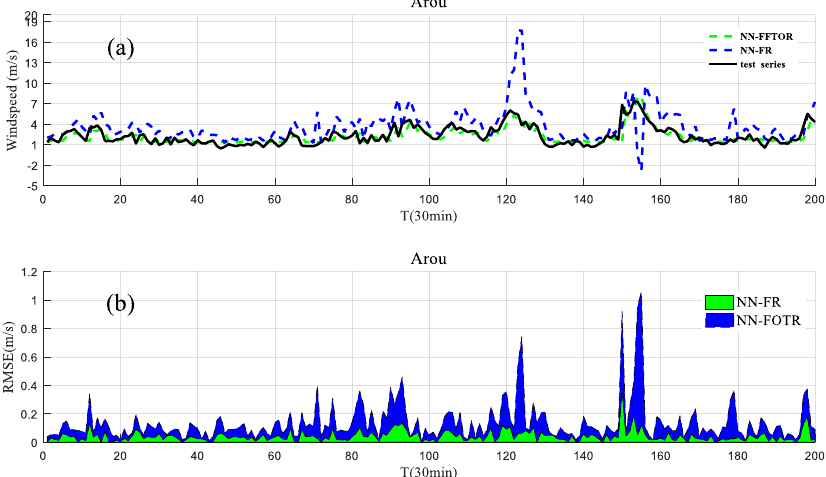
Figure 6. Results for the wind speeds at the Arou site. ( a ) Prediction, ( b ) RMSE) Table 3. Experimental parameters setting in the neural network model.